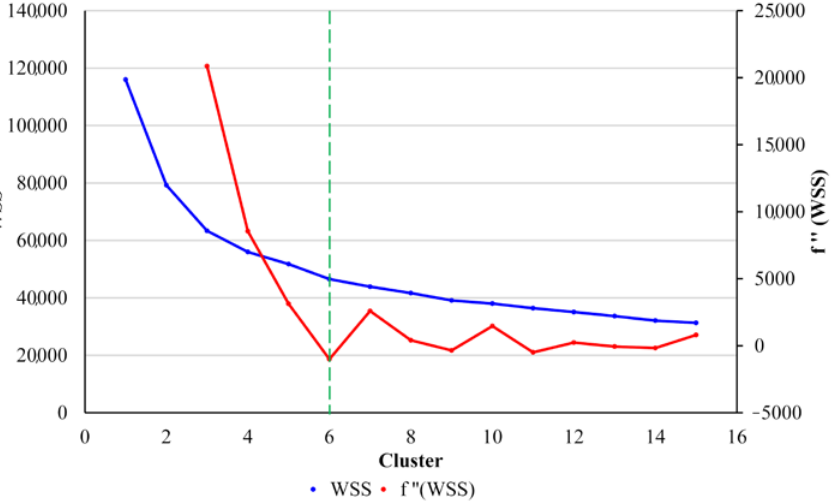
Figure 9. Total within - cluster sum of squares (WSS, blue line) and its second derivative ( f ″ (WSS), red line). The optimal number of significantly different clusters was found to be six (dotted green line), corresponding to the breaking value of f ″ .